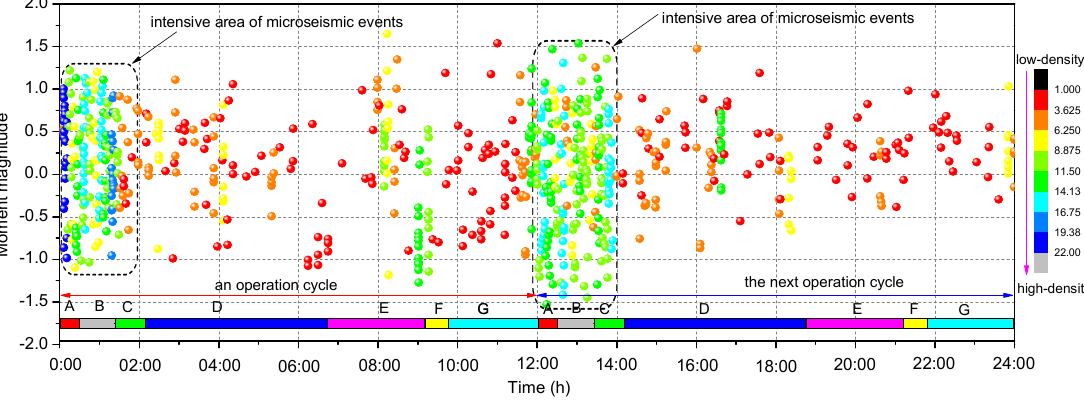
Figure 9. Time distribution law of MS events